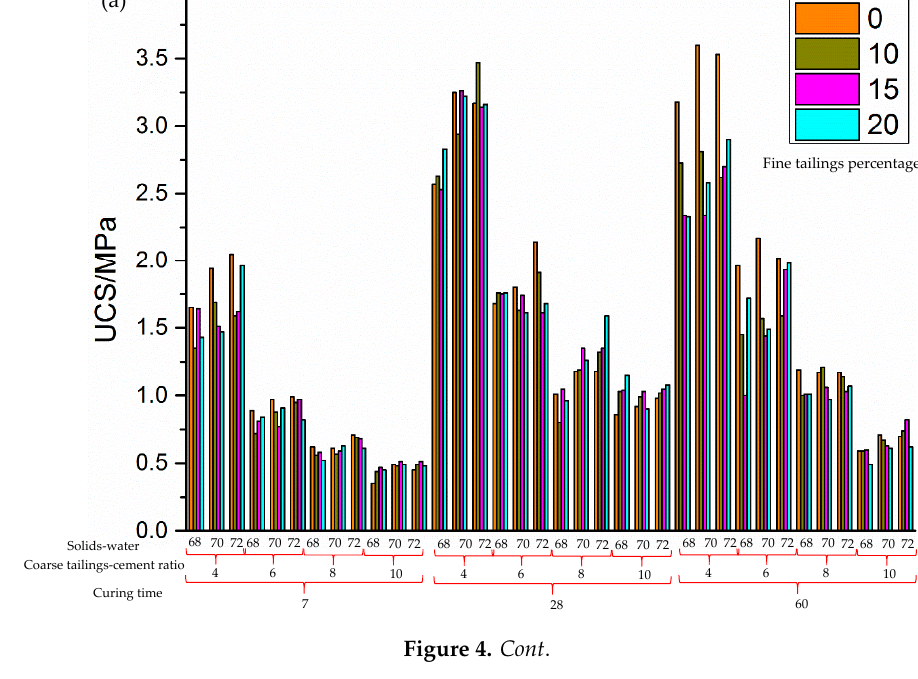
Figure 4. UCS test results of CPB in 4D. ( a ) 1# cement; ( b ) 2# cement.